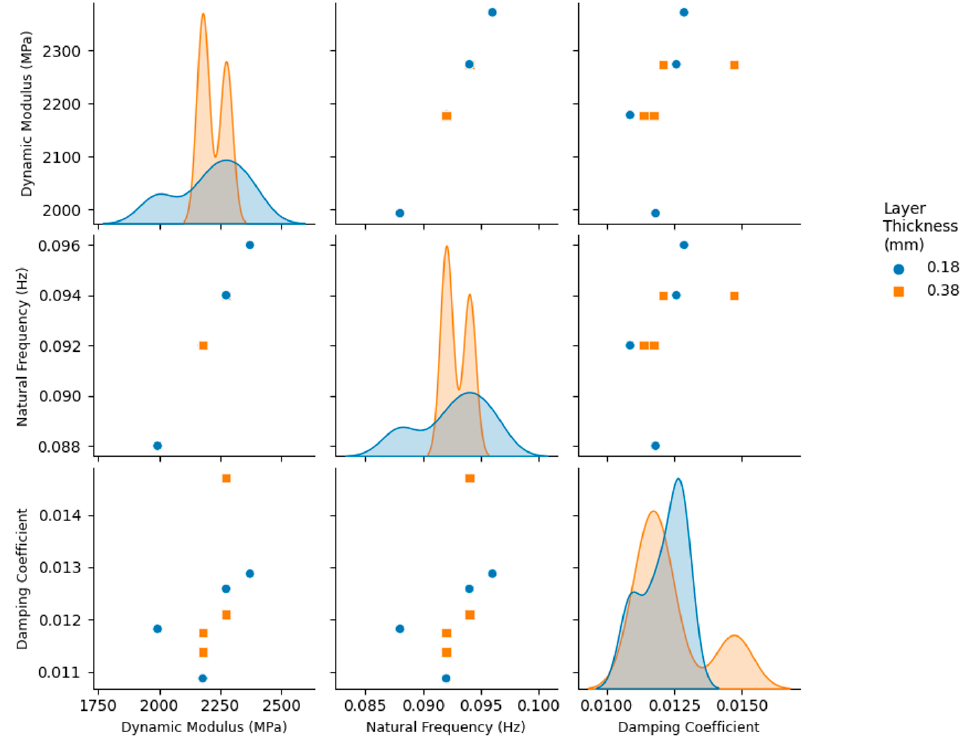
Figure 9. Pair plots of the modal analysis parameters obtained from the free-vibration tests of the 3D printed cantilevers. The variable of interest is the layer thickness (0.18 mm and 0.38 mm).